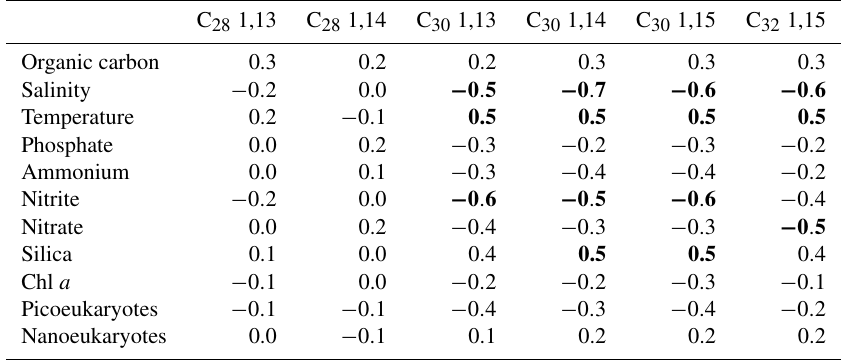
Table 2. Spearman rank correlation coefficients between LCD and environmental variables a